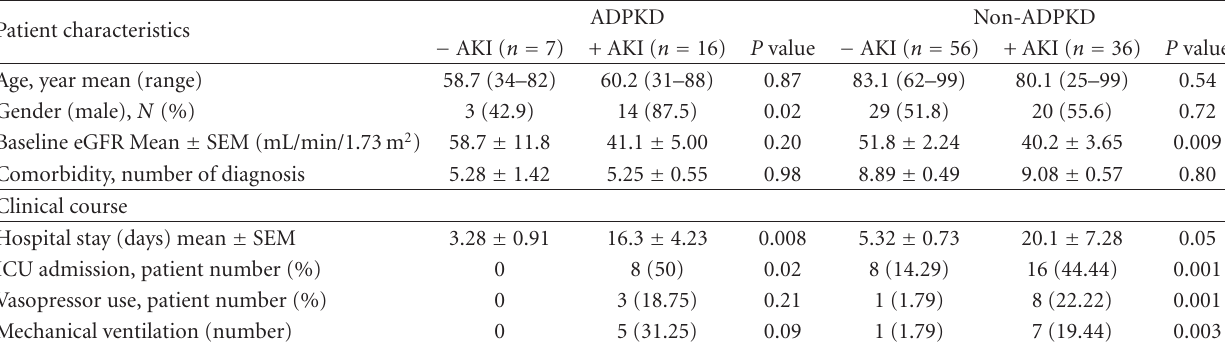
Table 3: Patient characteristics and clinical course in ADPKD and non-ADPKD patients with and without AKI. Patient